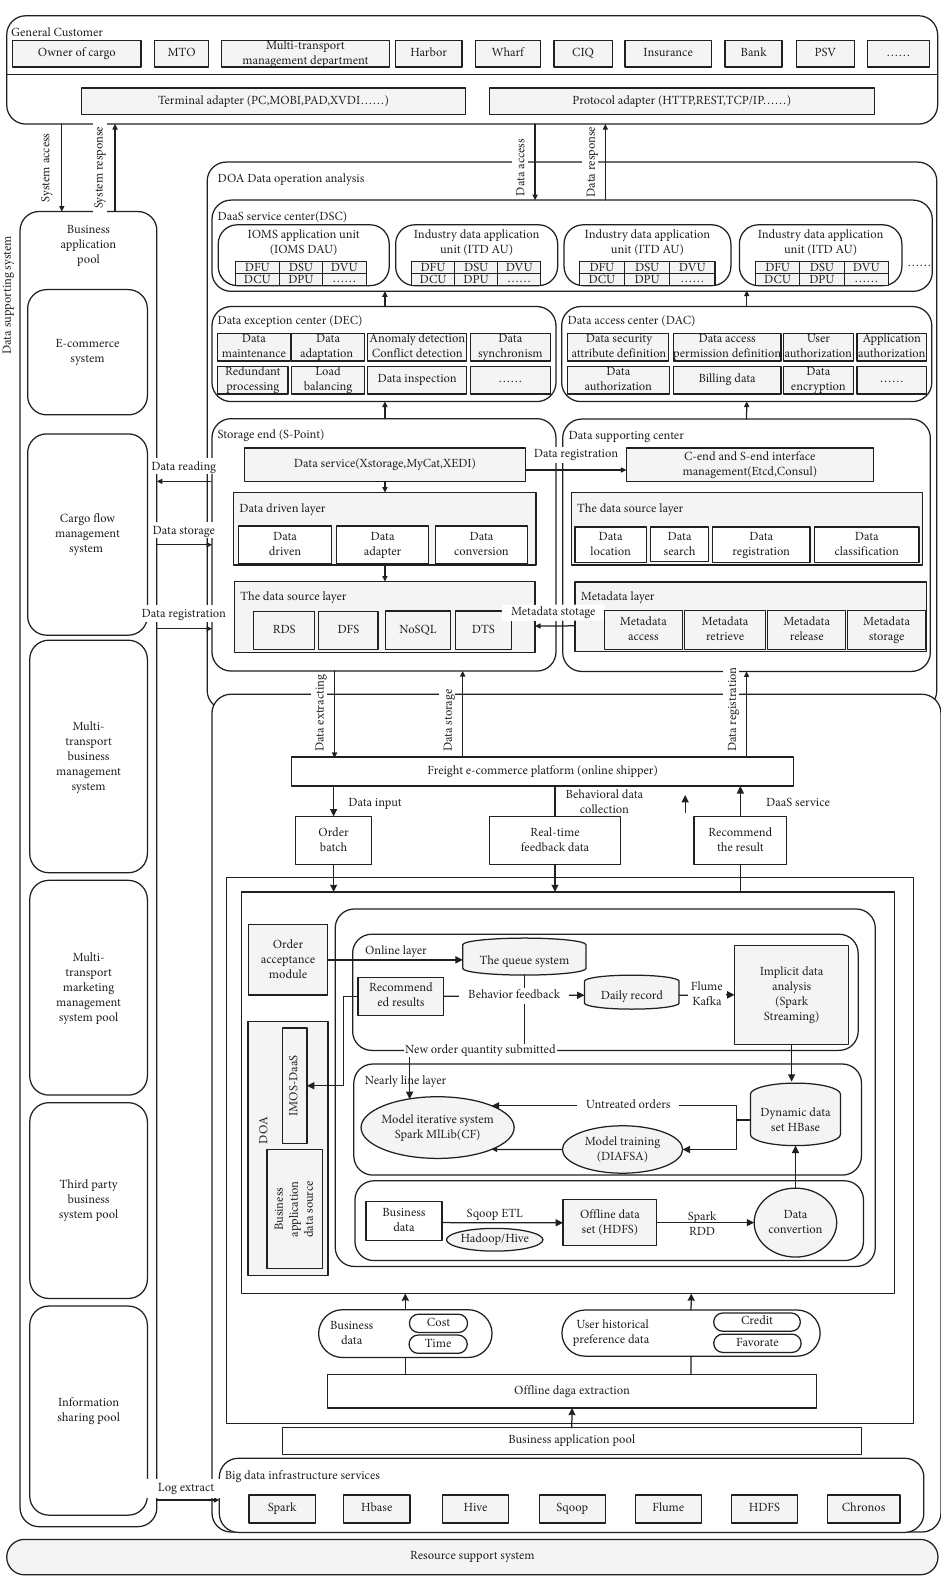
Figure 4: Data support